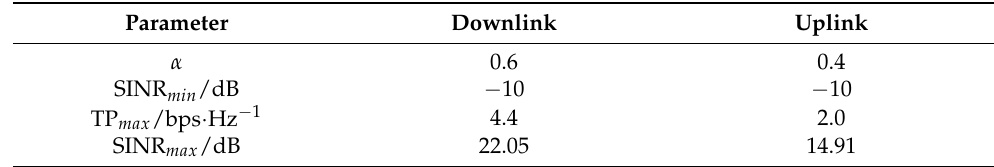
Table 9. LTE link performance